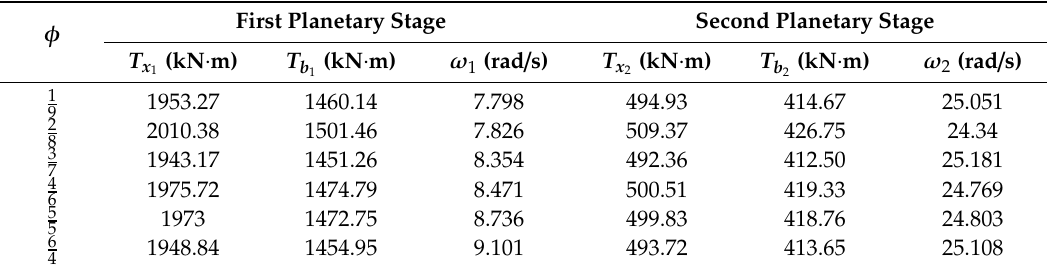
Table 8. Results of relevant